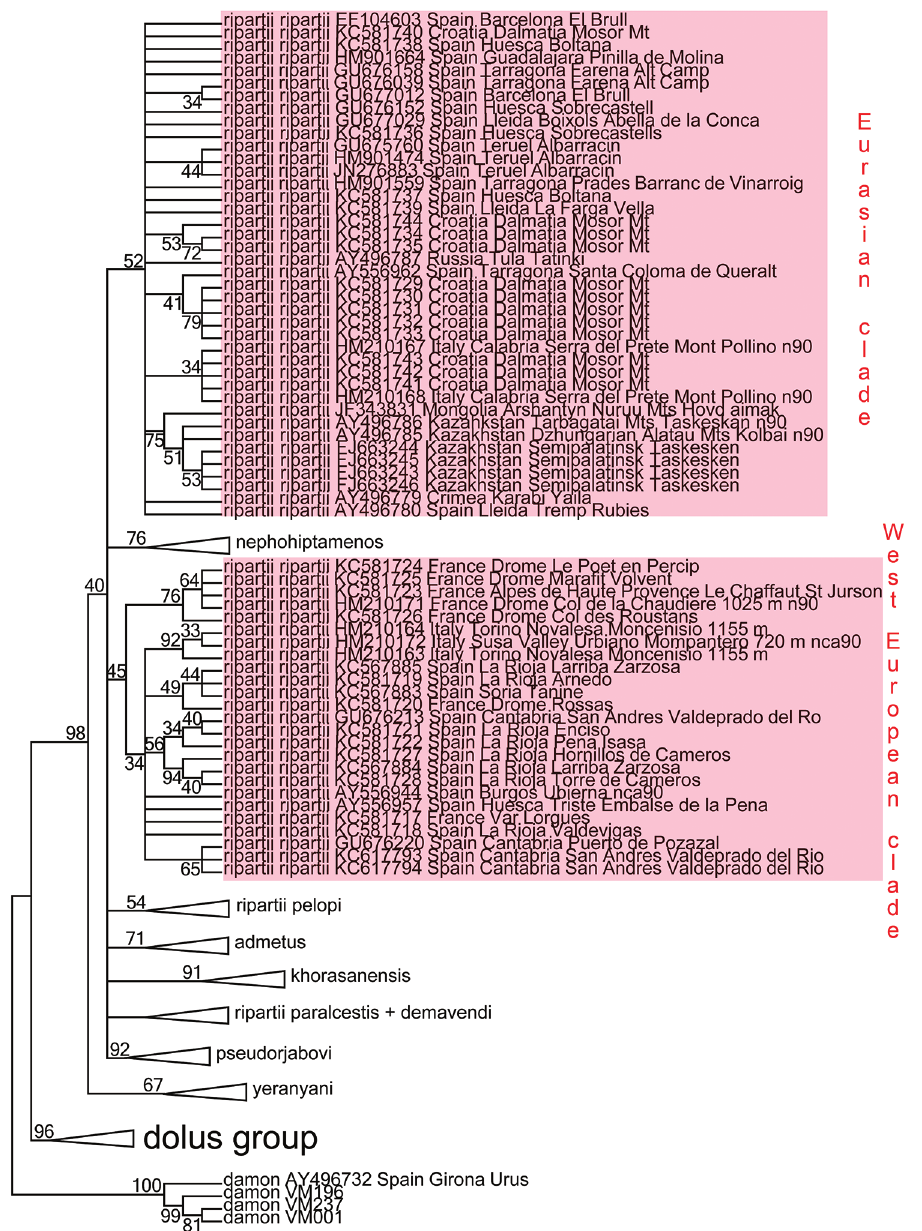
Figure 19. Fragment of the ML tree of P. admetus and P. dolus complexes based on analysis of COI barcodes and focused on details in the structure of the West-European and the “mixed” (Eurasian) clades of P. ripartii . Numbers at nodes indicate bootstrap